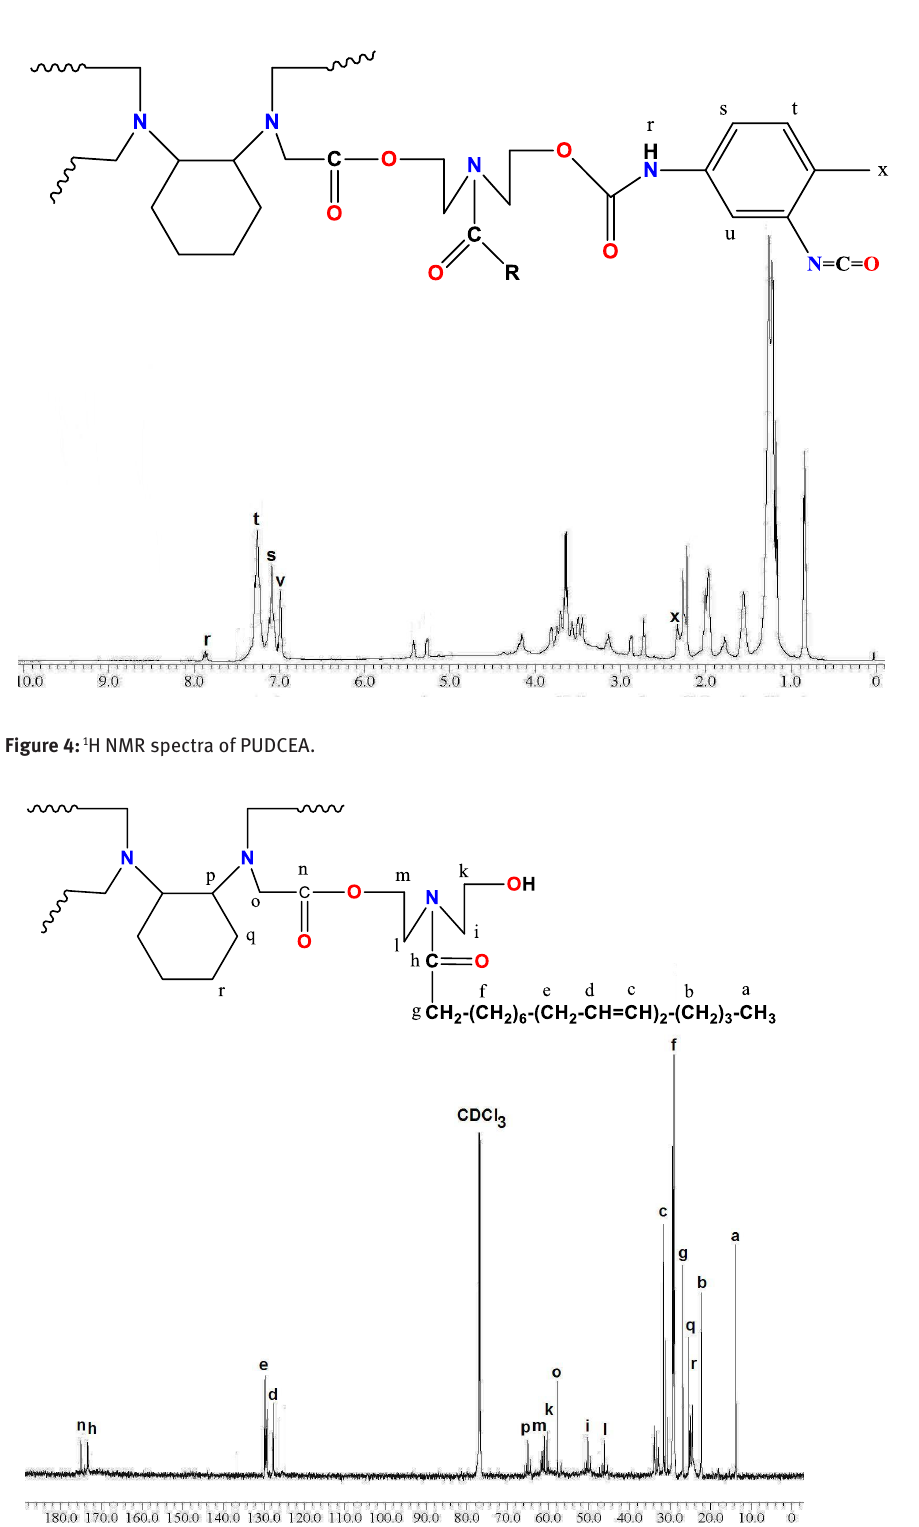
Figure 5. 13 C NMR spectra of PDCEA Figure 5: 13 C NMR spectra of